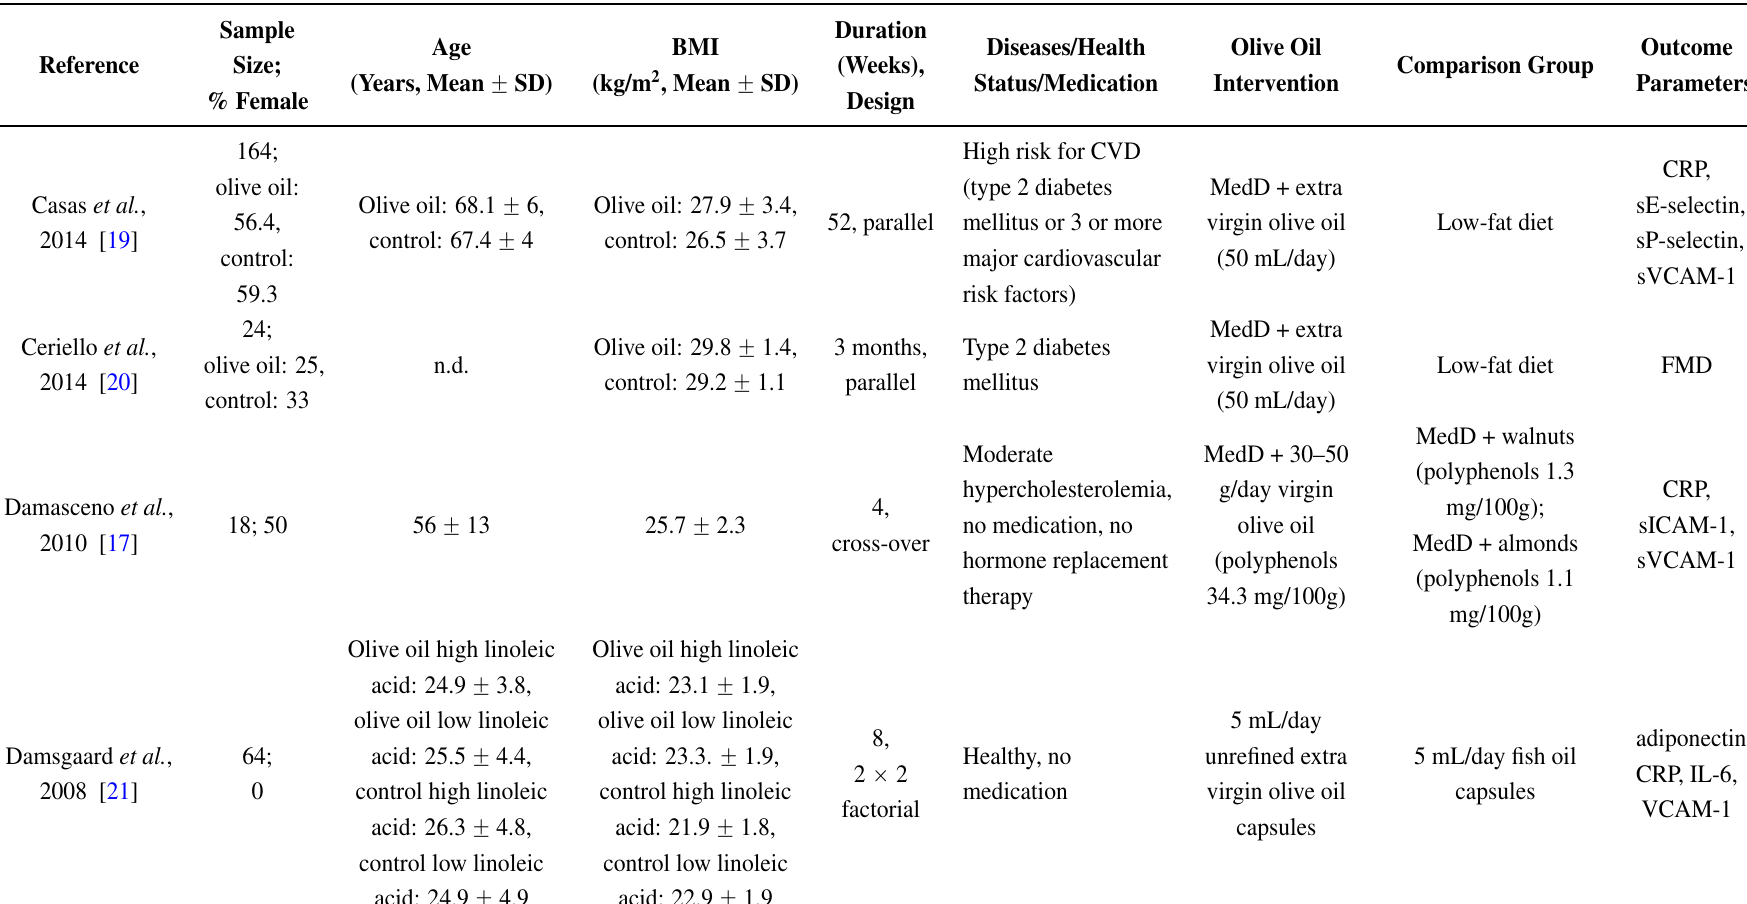
Table 1. General characteristics of randomized controlled trials included in the systematic